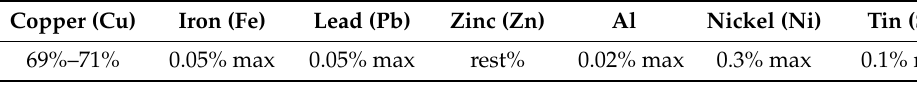
Table 2. Chemical composition of brass cone pipe (CuZn 3 O).